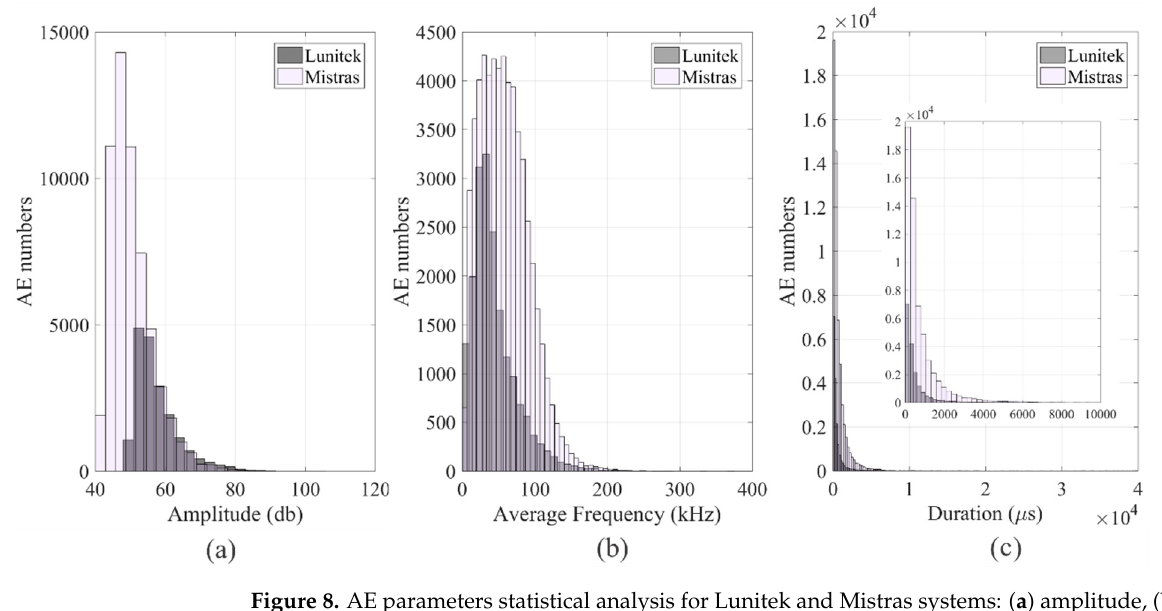
Figure 7. Relation between counts versus duration for: the ( a ) Lunitek and, ( b ) Mistras system. Amplitude in db is present in the colorbar.